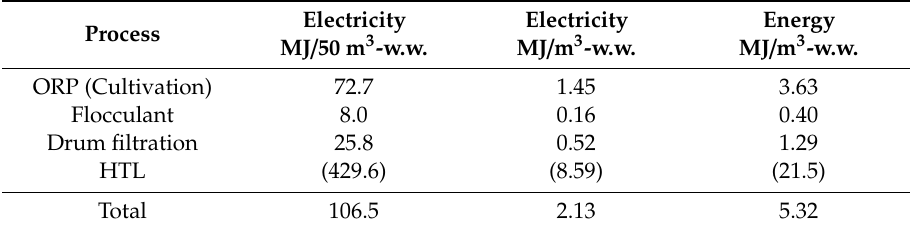
Table 12. Operating electricity from algal fuel